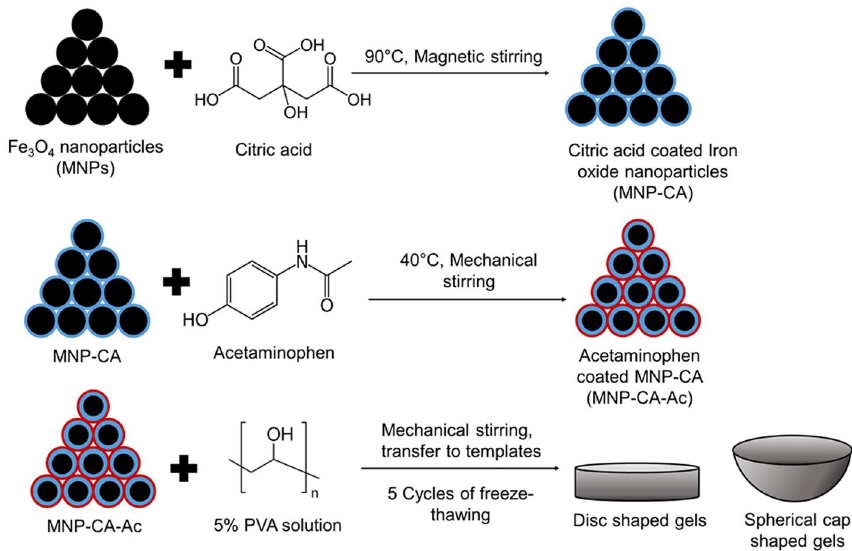
Figure 1. Schematic representation of the synthesis of disc and spherical cap shaped PVA-MNP-CA-Ac